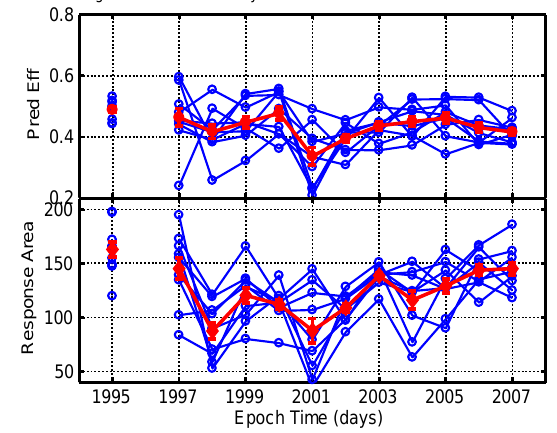
Fig. 9. The prediction efficiency and filter area of annual average filters for each day-long epoch relative to CIR stream interface are shown by blue circles. The heavy red lines with error bars show the average over all epochs and the standard error of the mean. No AE index data are available for 1996.